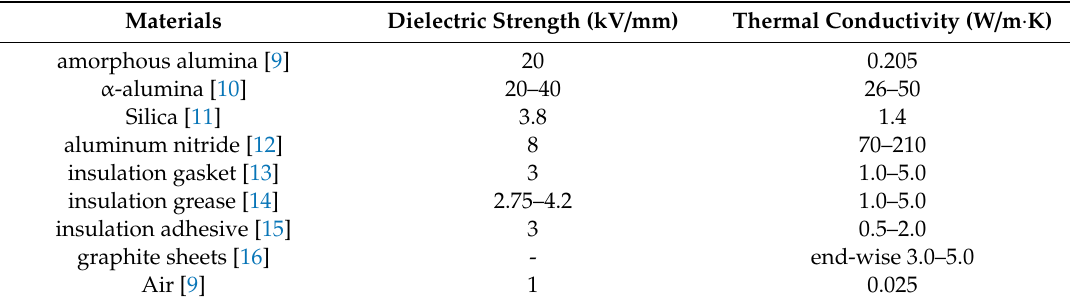
Table 1. Insulation and thermal conductivity of di ff erent